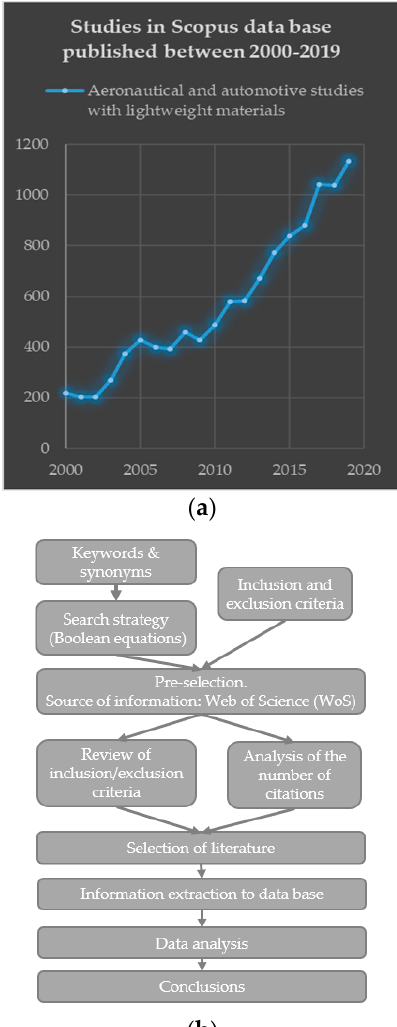
Figure 1. ( a ) Trend according to the number of studies on lightweight materials applied to the aeronautical and automotive sectors; ( b ) Defined strategy for literature search.